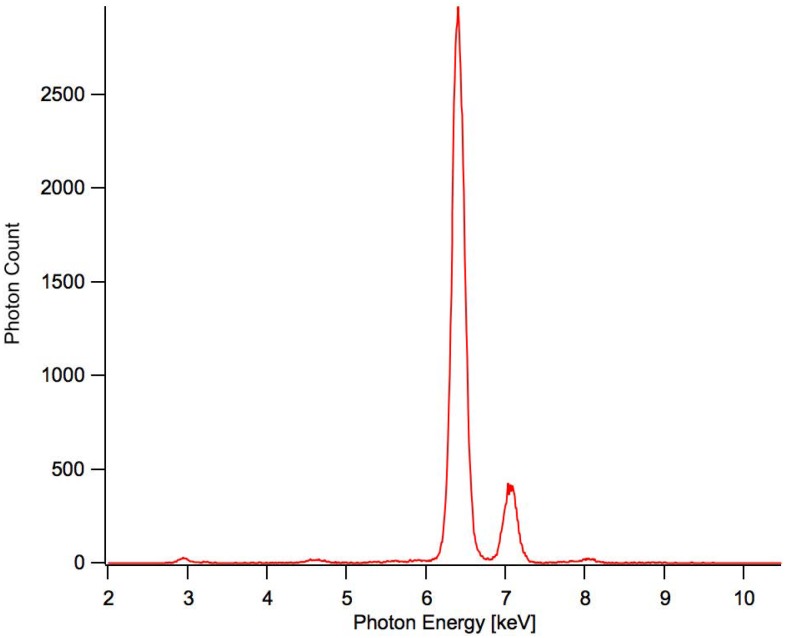
Iron (Fe) XRF irradiation spectrum.Displaying photon count vs. photon energy [keV].